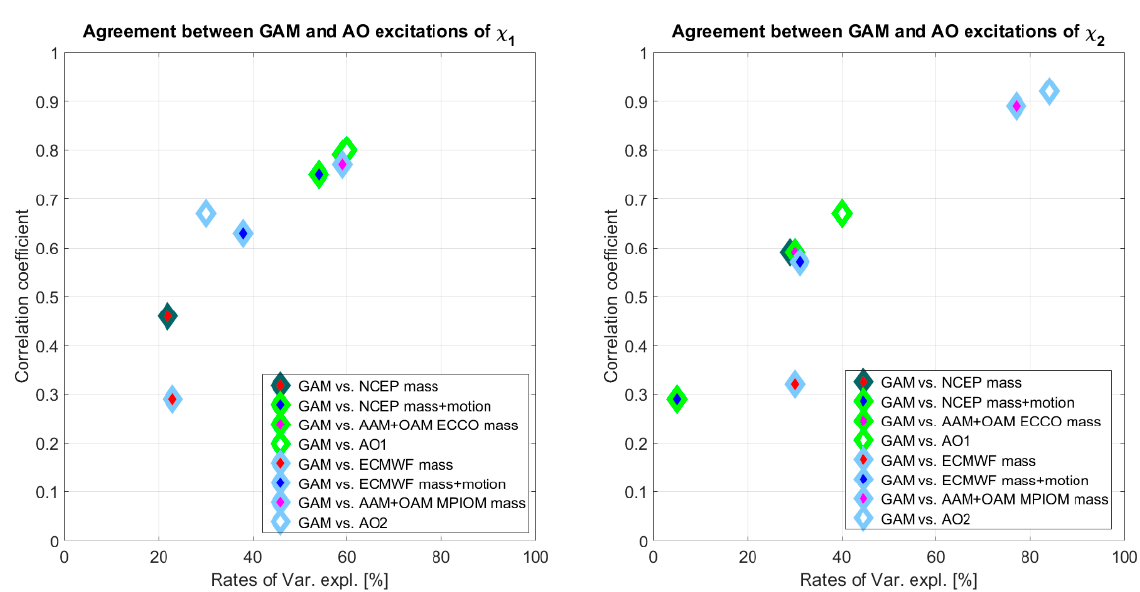
Figure 4. Correlation coefficients and rates of explained variance between geodetic and geophysical components of mass and motion terms and their combinations of interannual PM excitations, for χ 1 ( left panel ), and χ 2 ( right panel ).